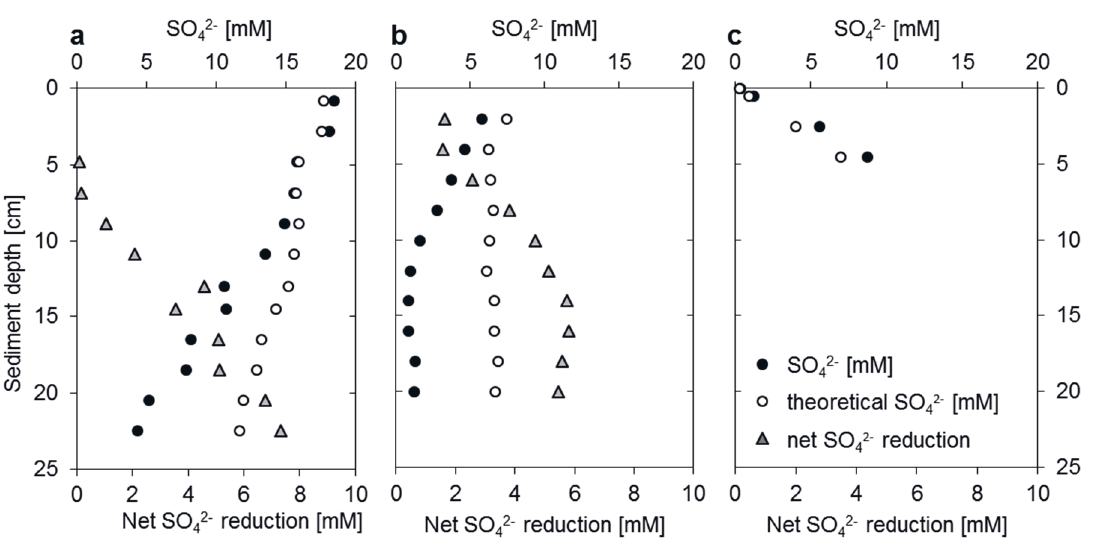
Figure 4. Pore water profiles of measured ( black dots ) and salinity-based ( open dots ) SO 42 − concentrations and net SO 42 − reduction ( gray triangles ) in March ( a ); regular summer in September ( b ); and post-storm conditions in October ( c